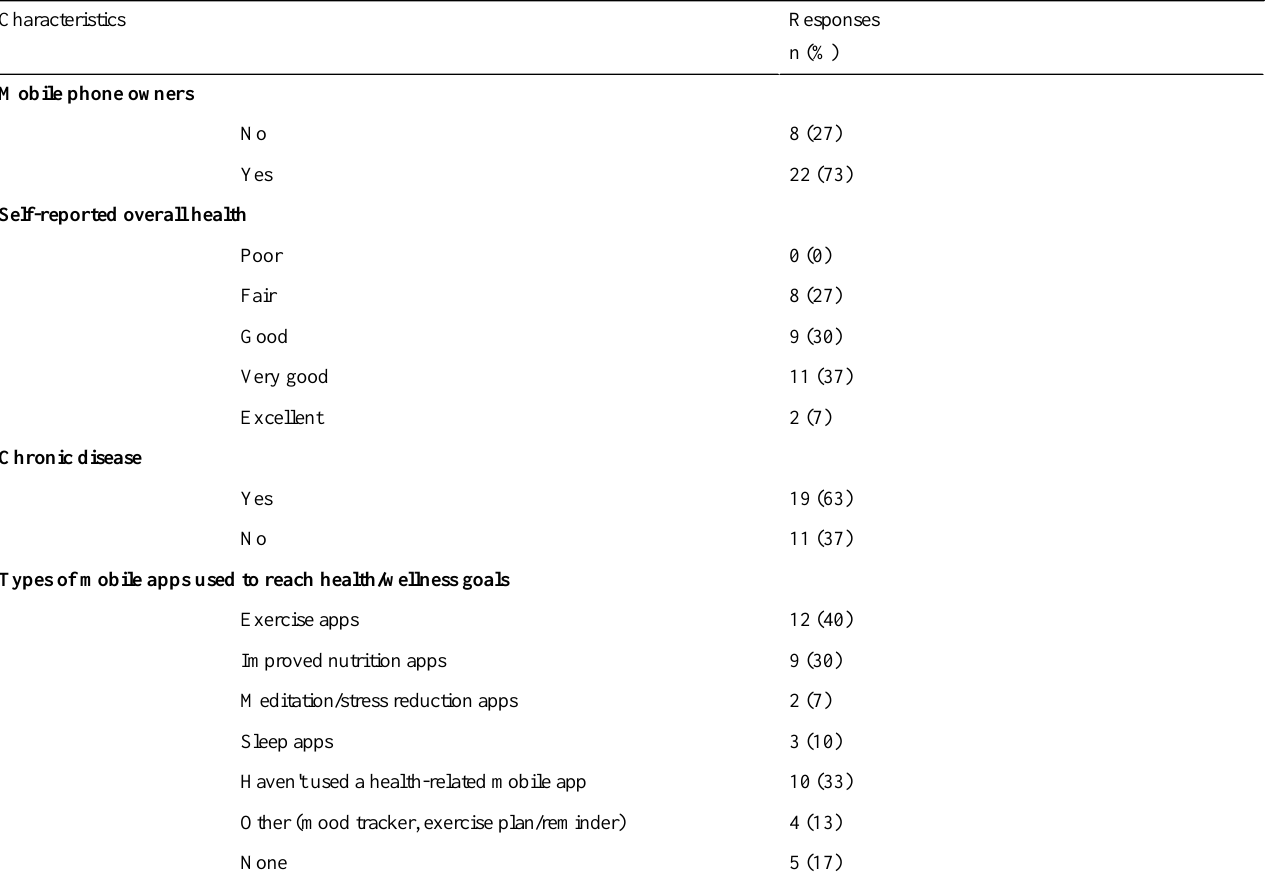
Table 2. Technology experience and self-rated health of focus group participants